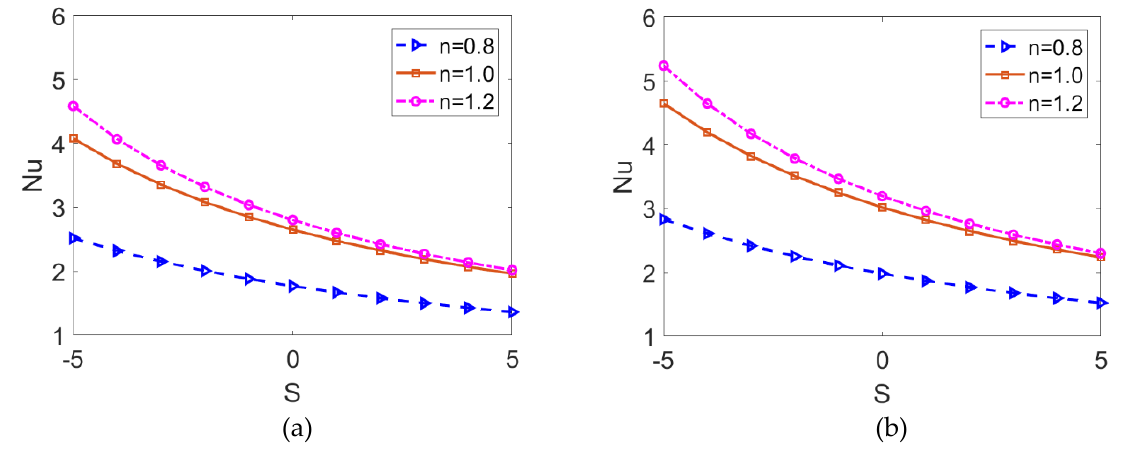
Figure 9. The variation of Nusselt number with Joule heating parameter for shear thinning nanofluid, Newtonian nanofluid, and shear thickening nanofluid in the case of ( a ) ϕ =0 and ( b ) ϕ =0.06.